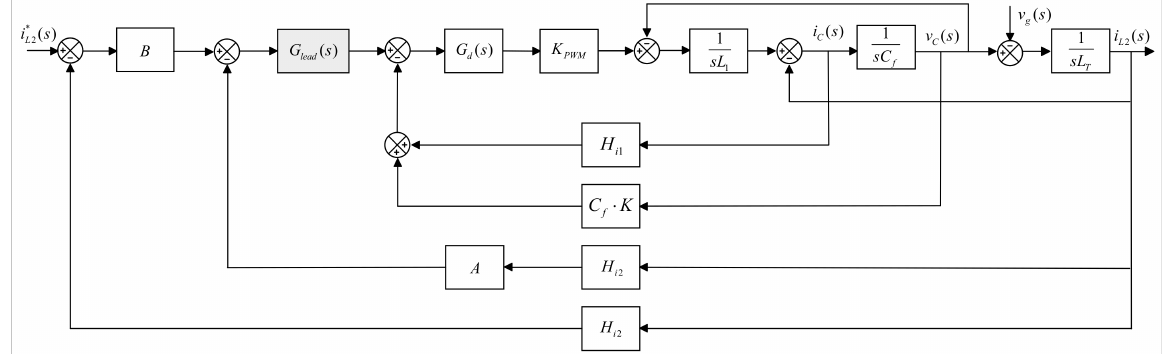
Figure 23. Block diagram of the proposed method transformed from Figure